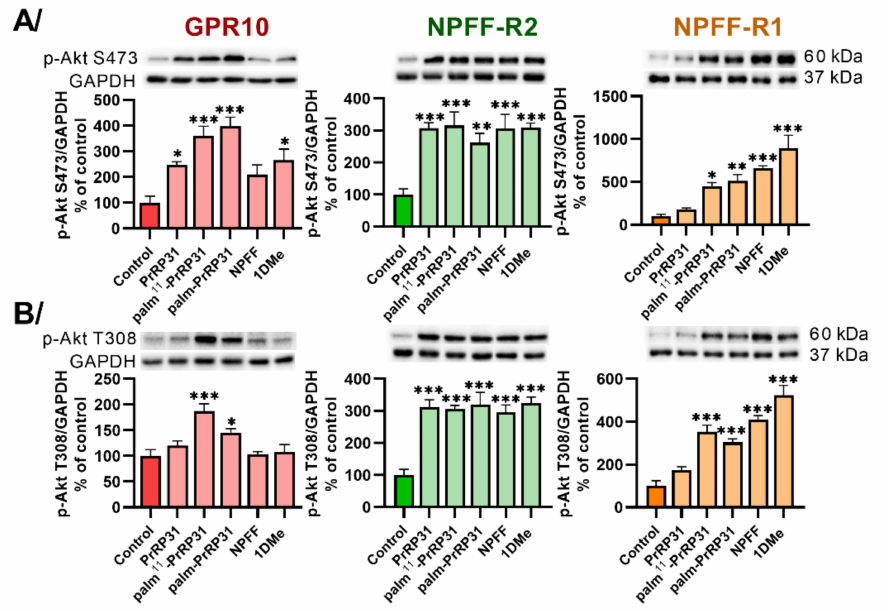
Figure 2. Induction of ( A ) Akt (S473) and ( B ) Akt (T308) phosphorylation after 5 min of incubation at 37 ◦ C with peptides at final concentrations of 10 − 6 M in CHO-K1 cells expressing receptors GPR10, NPFF-R2 and NPFF-R1. Densitometric quantification was normalized to GAPDH, and the phosphorylation level in the untreated control was standardized as 100%. Data are presented as the mean ± SEM and analyzed by two-way ANOVA followed by Dunnett’s post hoc test. Experiments were performed independently at least three times. Statistically significant differences from the control are indicated (* p < 0.05, ** p < 0.01, *** p <